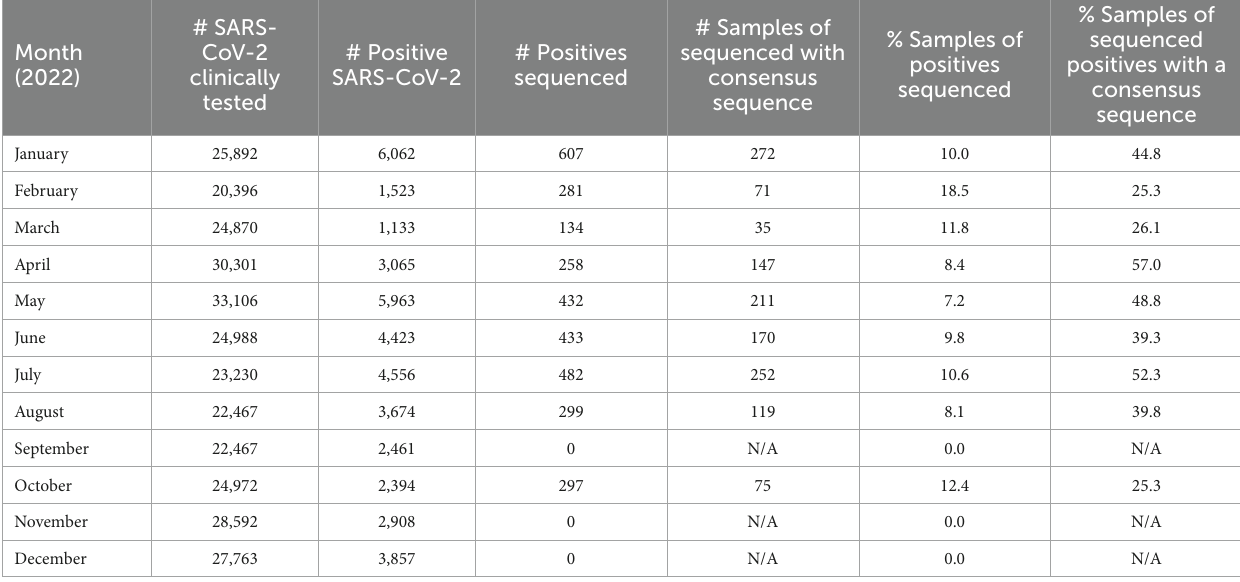
TABLE 1 Summary of SARS-CoV-2 samples tested clinically and sequenced at NSUHS for 2022.